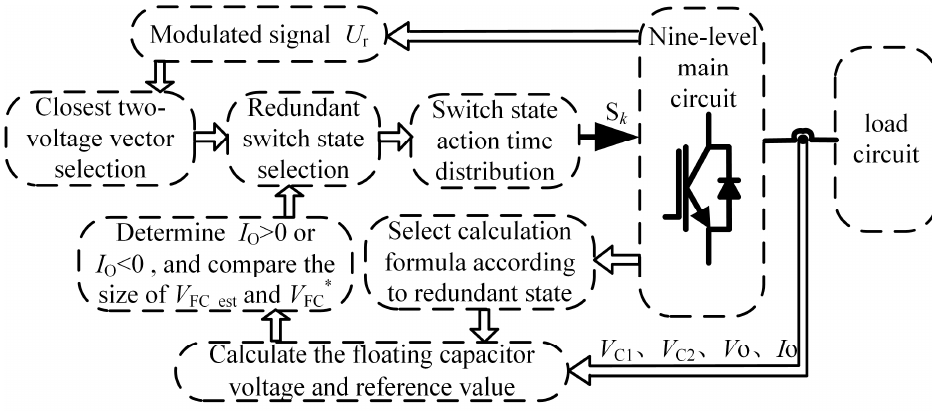
Figure 8. The block diagram of the proposed floating capacitor voltage sensorless control scheme.